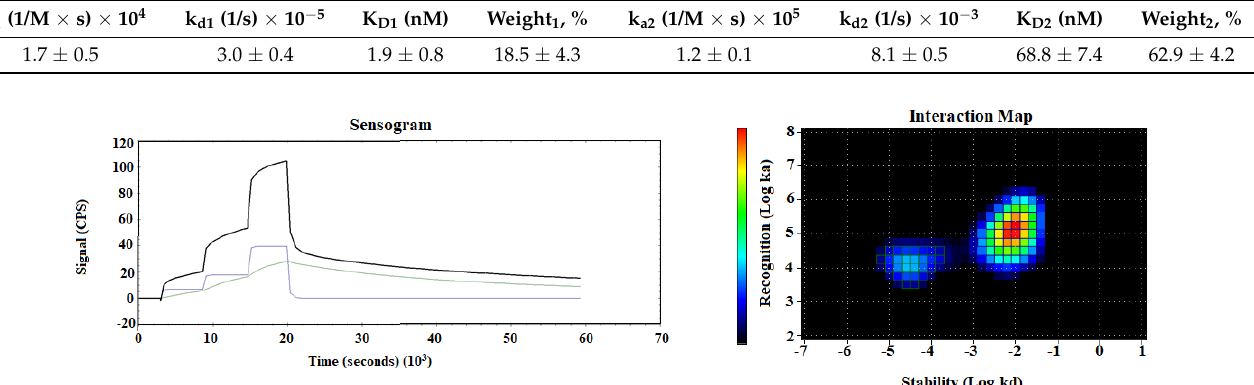
Figure 6. LigandTracer sensorgram and InteractionMap of [ 99m Tc]Tc-AC12-GGGC binding to SKOV-3 cells. Input data were obtained from LigandTracer measurement of cell-bound activity during association of labelled conjugate to- and dissociation from SKOV-3 cells. Binding was measured at three different concentrations: 2, 6, and 18 nM. Measurement was performed in duplicates. Table 1. Apparent equilibrium dissociation constants (KD) for the interaction between [ 99m Tc]Tc- AC12-GGGC and SKOV-3 cells determined using an InteractionMap analysis of the LigandTracer sensorgrams.